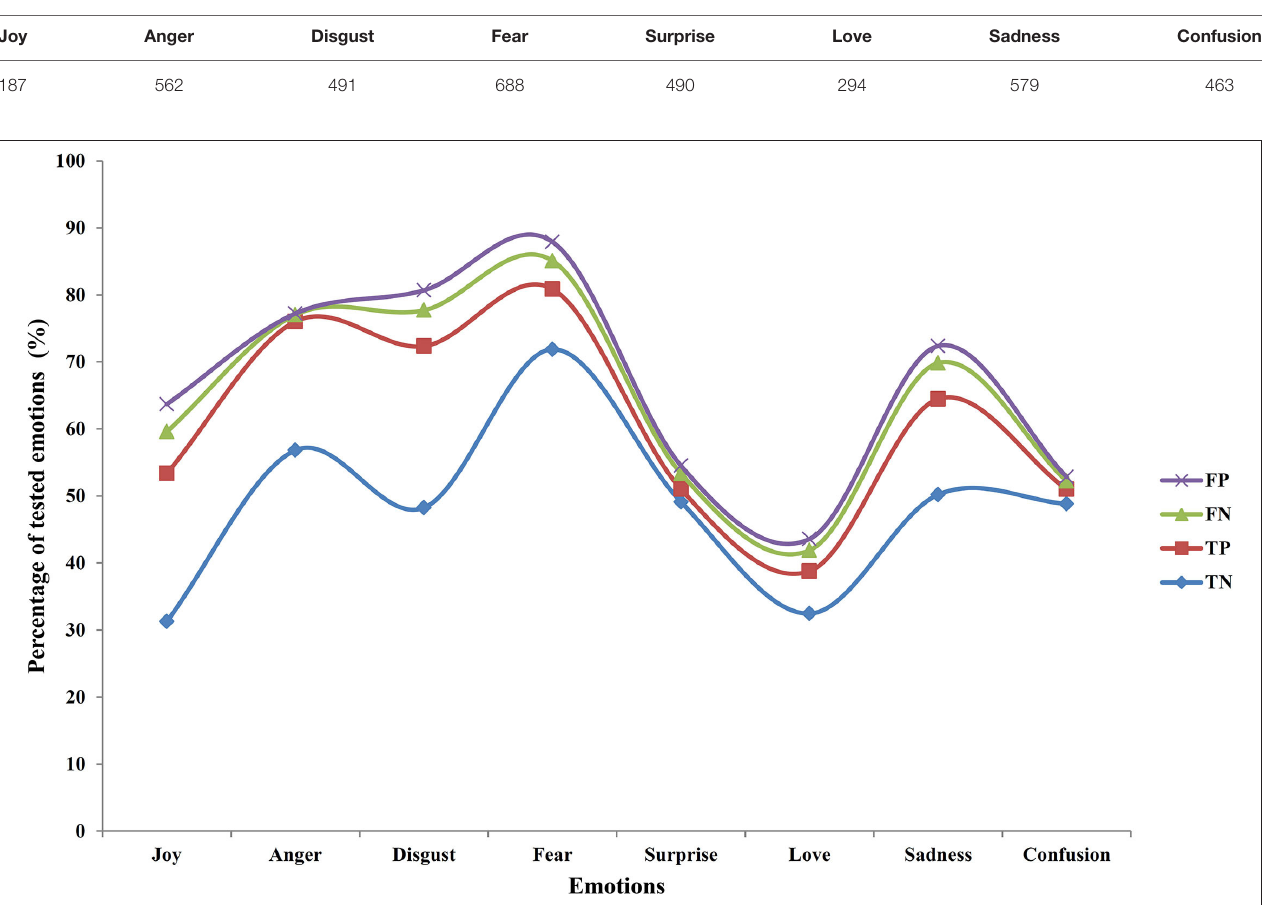
FIGURE 4 | Percentage of TP, TN, FP, and FN.